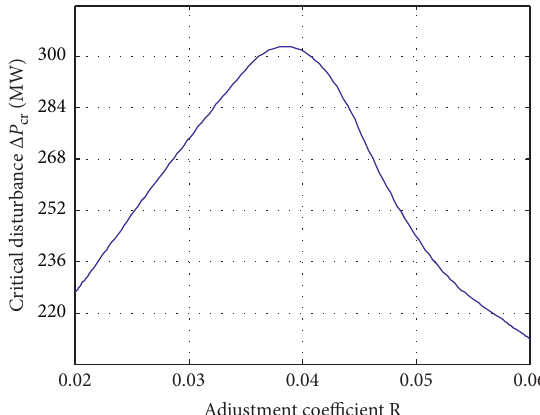
Figure 9: Critical disturbance amount curve after optimization of adjustment